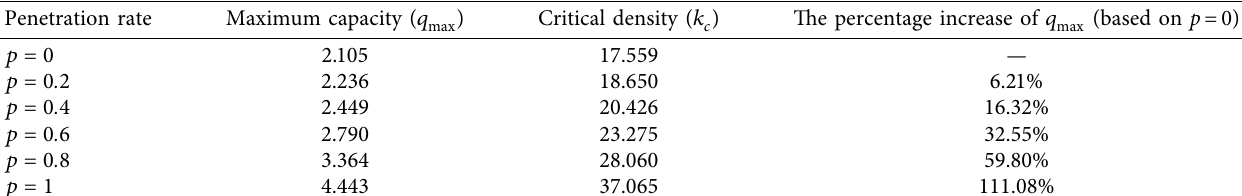
Table 2: Key parameters of the fundamental diagram under different CAV penetration